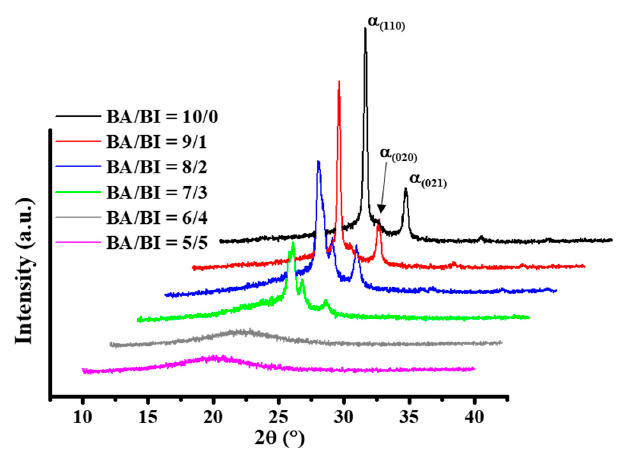
Figure 6. XRD patterns of PBABI copolyesters with different BA/BI ratios.